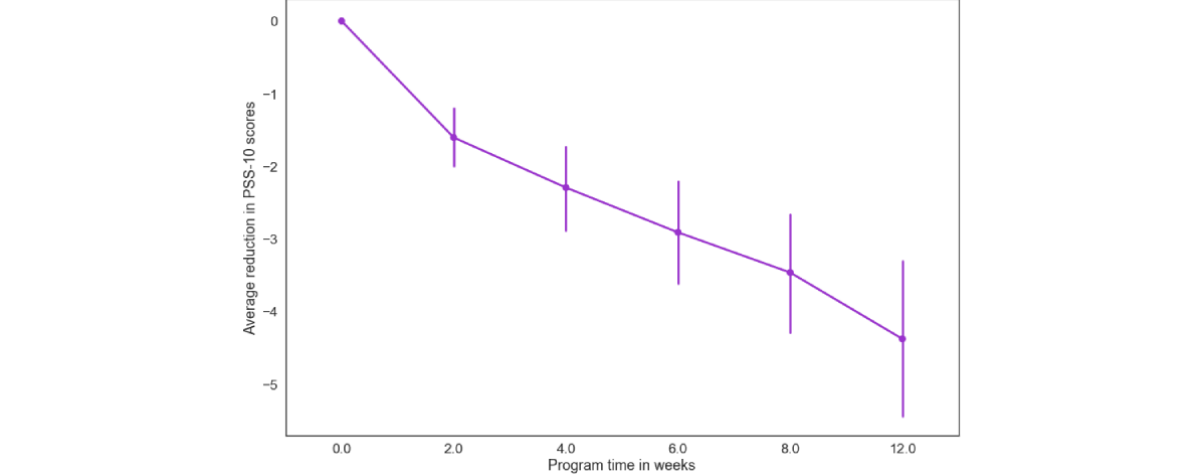
Figure 5. Estimated marginal means of changes in 10-item Perceived Stress Scale as a function of program time. PSS: Perceived Stress